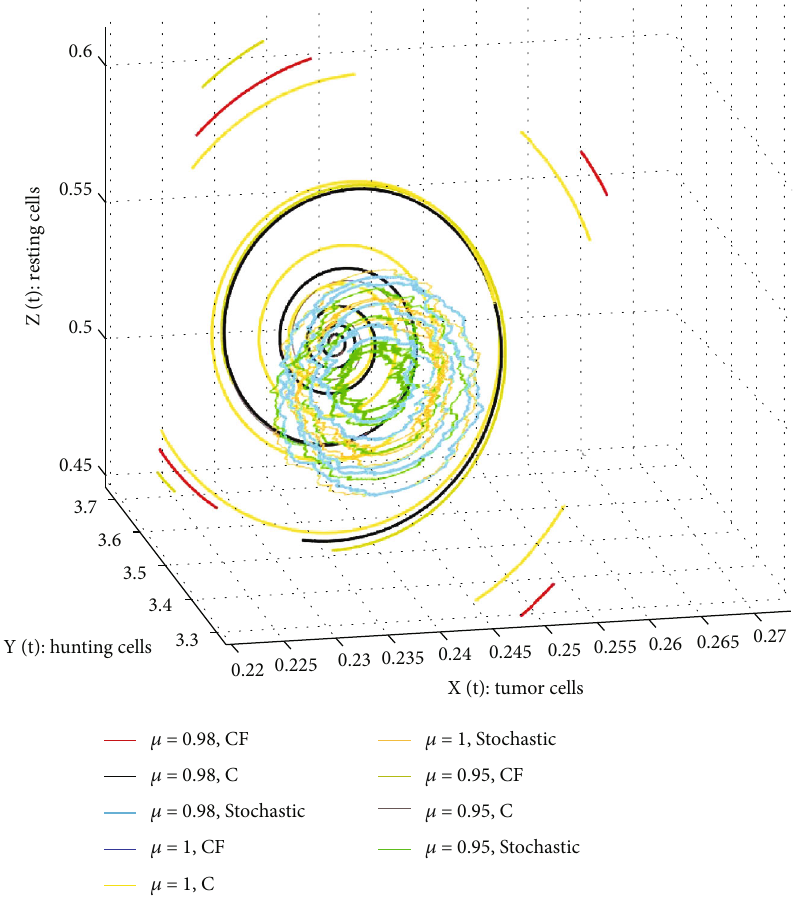
Figure 14: Zooming in on the inner part of Figure